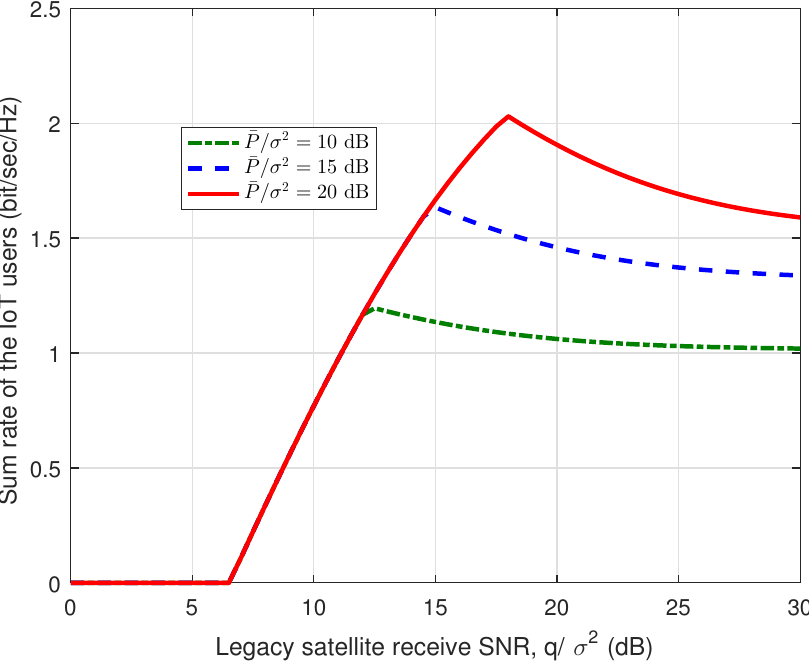
Figure 3. Sum rate of the IoT users vs. legacy satellite receive